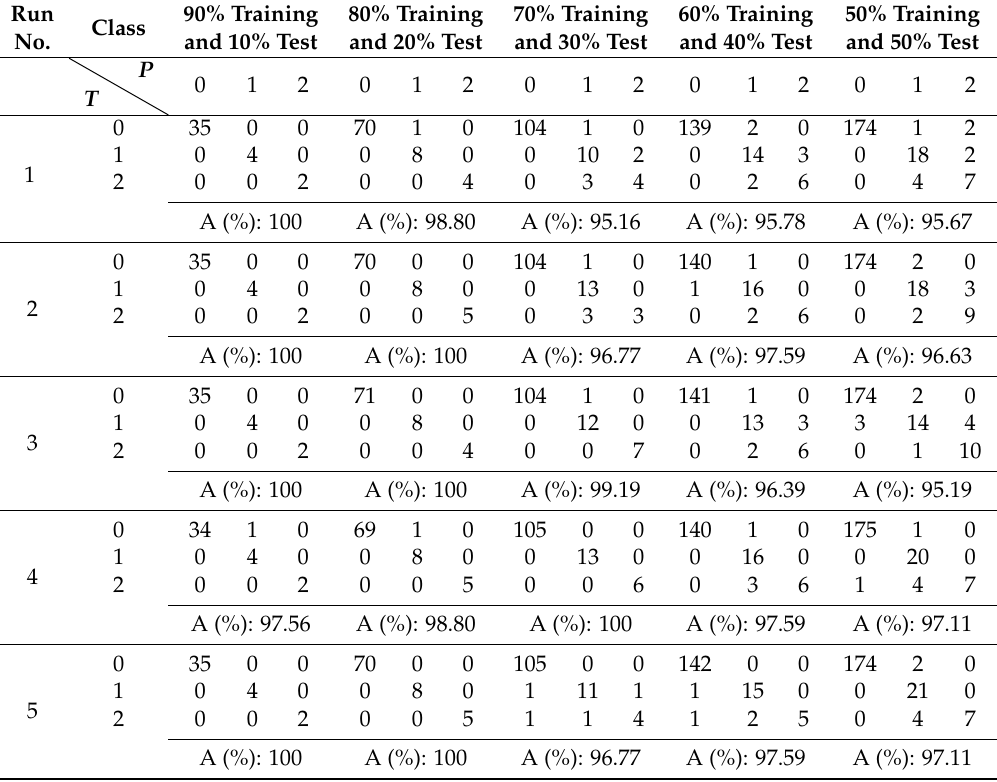
Table 7. Decision tree classifier accuracy results and confusion matrices from different training and test